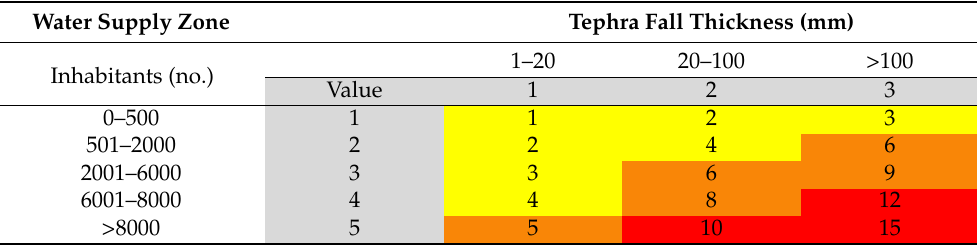
Table 4. Vulnerability matrix for the number of inhabitants being served by the system (threshold values for tephra fall thickness adapted from [3]. Tolerance status (1–4) in yellow, disturbance in orange (5–9) and damage in red